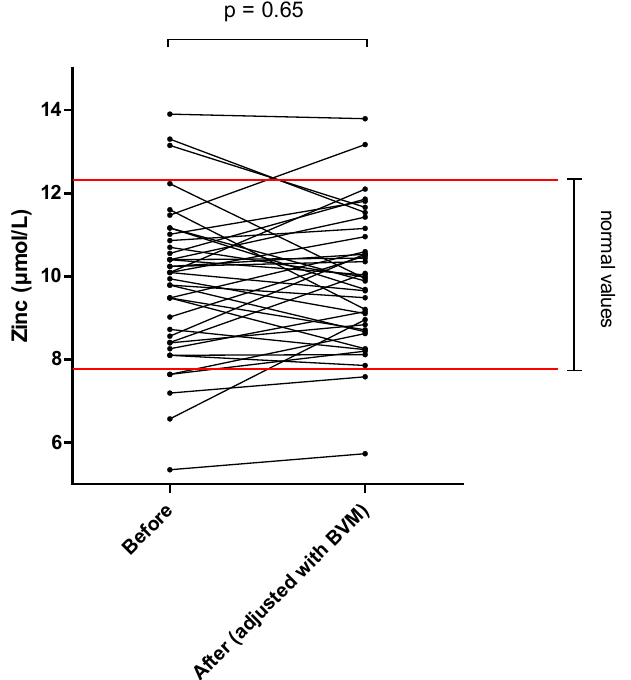
Figure 6. Vitamin C (ascorbic acid) blood concentration before and after one 4 h-HDF session (paired t- test).